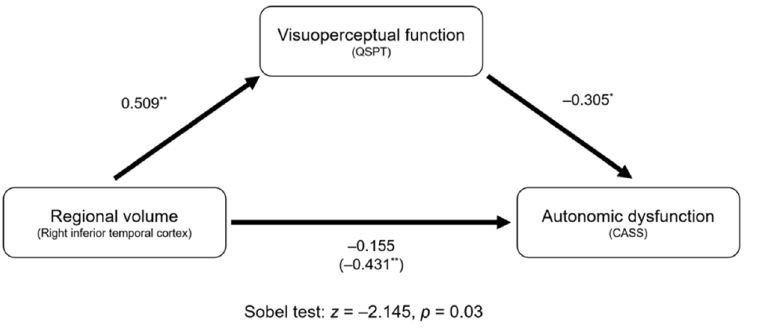
Figure 3. Mediation analysis for autonomic dysfunction. Unstandardized coefficients are presented. The number in parenthesis (i.e., -0.431) indicates the direct effect of regional volume in the right inferior temporal cortex on the autonomic dysfunction. Lesser indirect effect coefficient (i.e., -0.155) than direct coefficient indicates the presence of mediation effect. * p < 0.05, ** p <